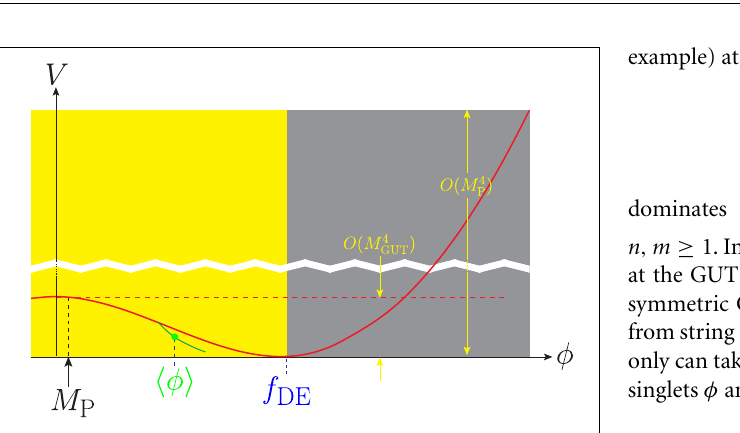
FIGURE 7 | The hilltop inflation [159]. The green bullet is the point whose effects are observed by the BICEP2 group.